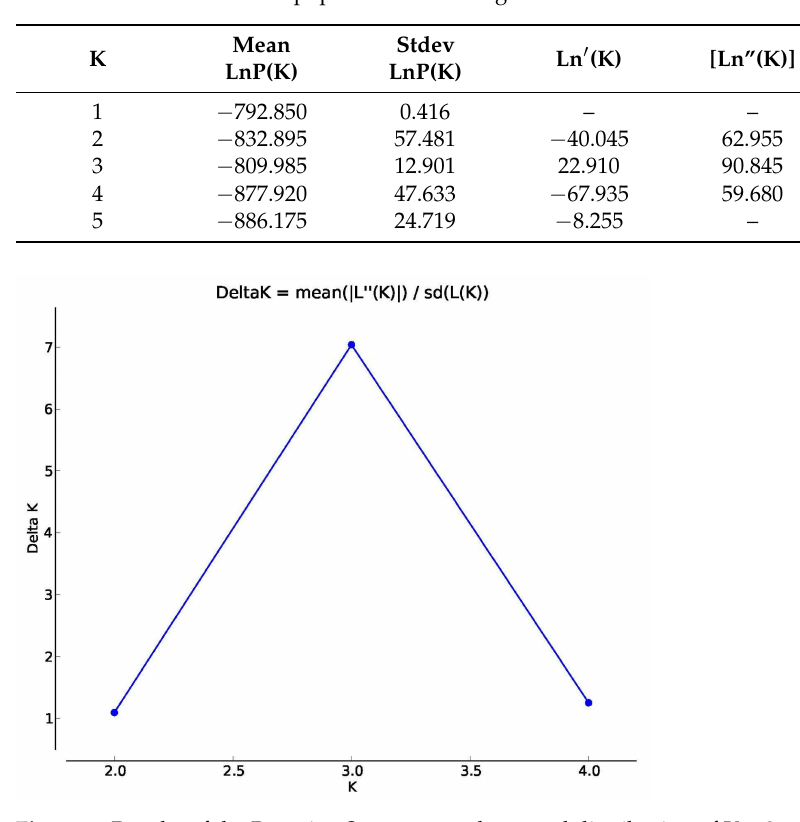
Figure 5. Results of the Bayesian Structure analyses and distribution of K = 3 population